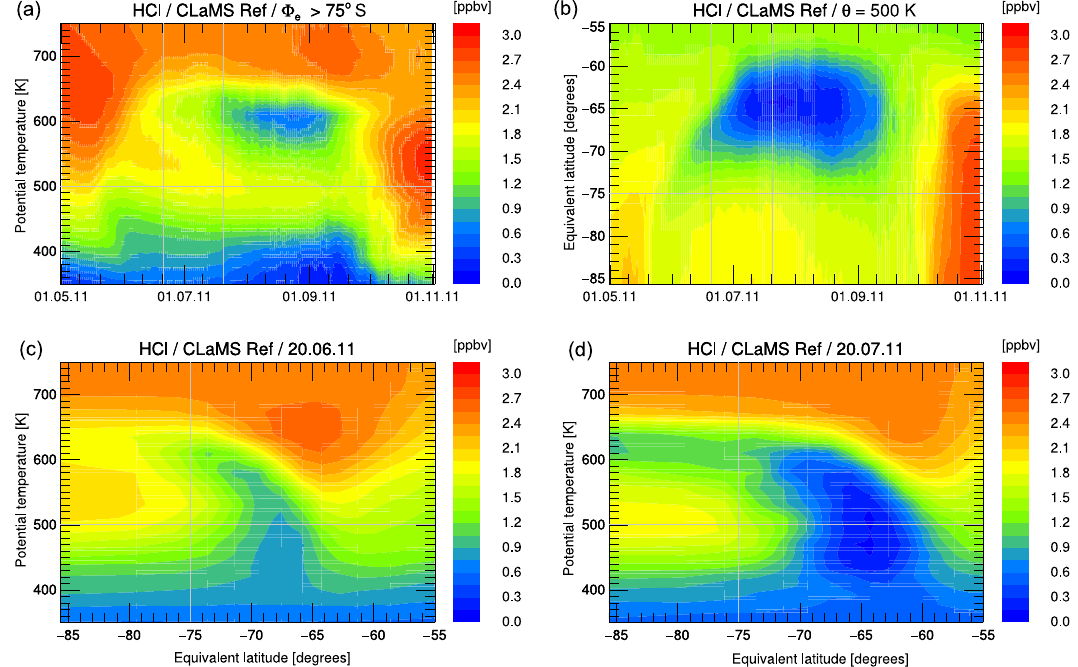
Figure 3. CLaMS simulation for HCl averaged in equivalent latitude/potential temperature space displayed as in Fig.